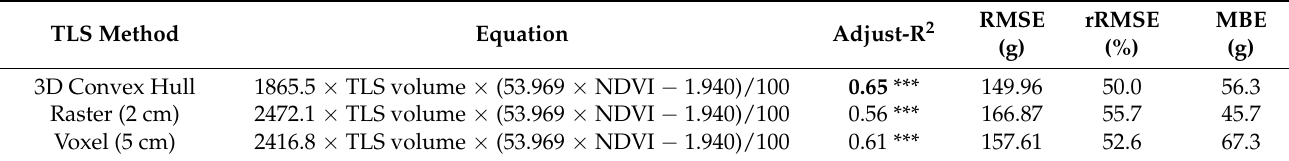
Table 5. Linear regression equations derived by OLS between GB (g) and plant volume (m 3 ) obtained by the three different TLS methods (3D convex hull, voxel, and raster-based models) and the NDVI. Values in bold reflect the best fit for each approach. *** indicates significant relationship at p -values <